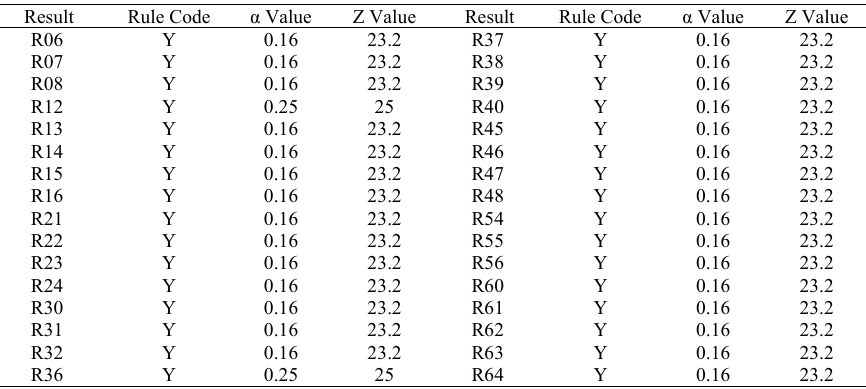
TABLE 7 D EGREE OF M EMBERSHIP S YMPTOMS OF I